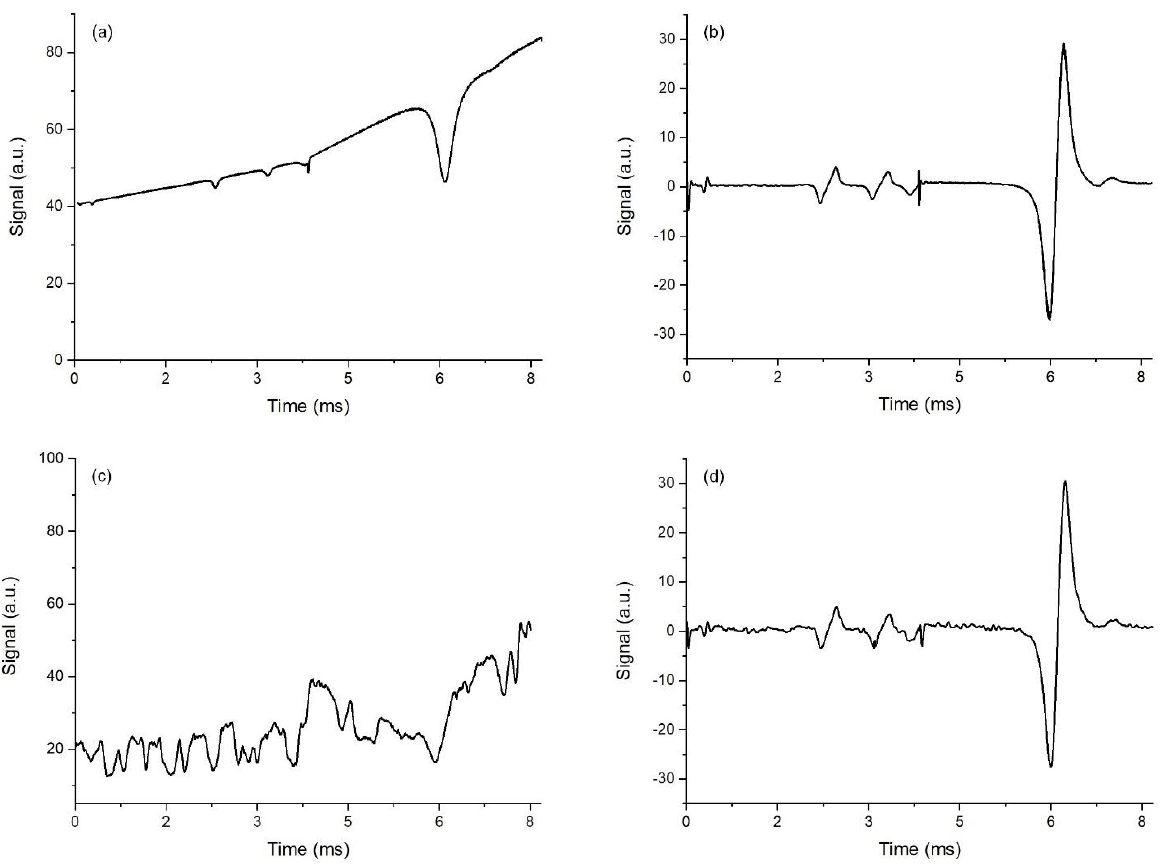
Figure 4. Raw data of a single scan detected in DAS mode (left panels) and log-WMS-1 f mode (right panels); disk off — ( a , b ); disk on — ( c , d ). panels); disk off—( a , b ); disk on—( c , d